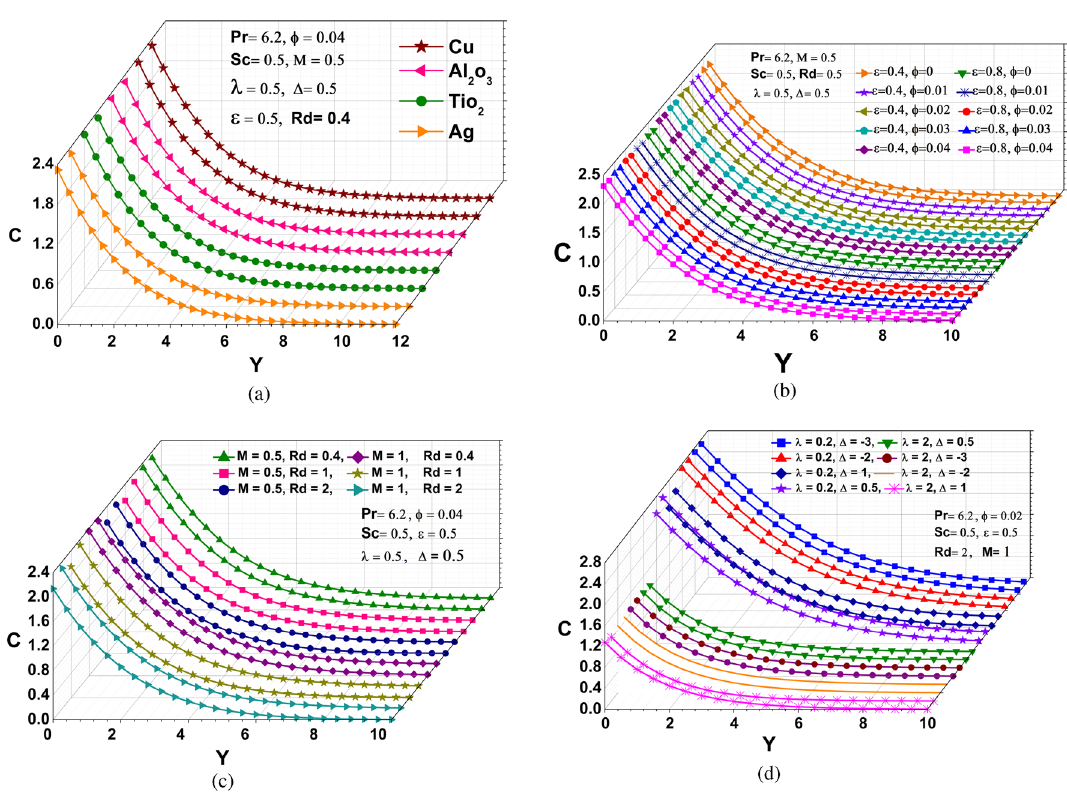
Figure 4. Concentration profiles: ( a ) different nanoparticles ( b ) various ǫ and φ ( c ) distinct M and Rd ( d ) different (cid:31) and (cid:31)